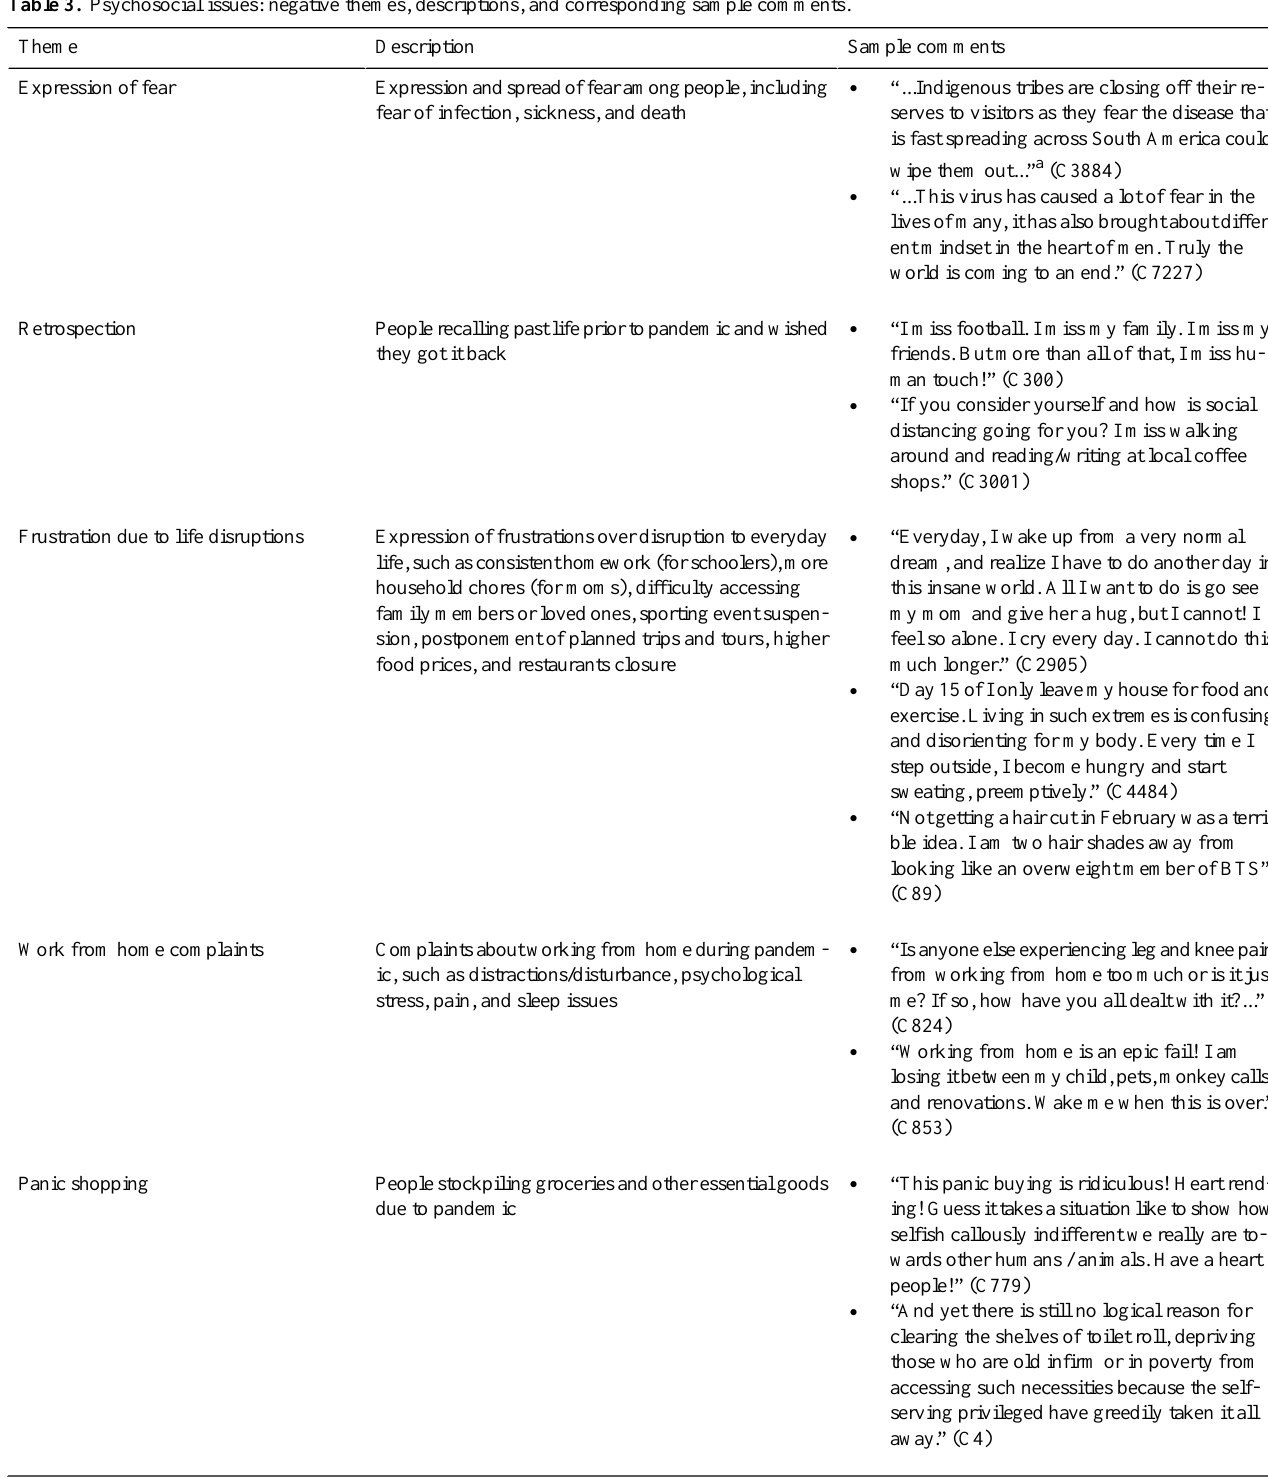
Table 3. Psychosocial issues: negative themes, descriptions, and corresponding sample